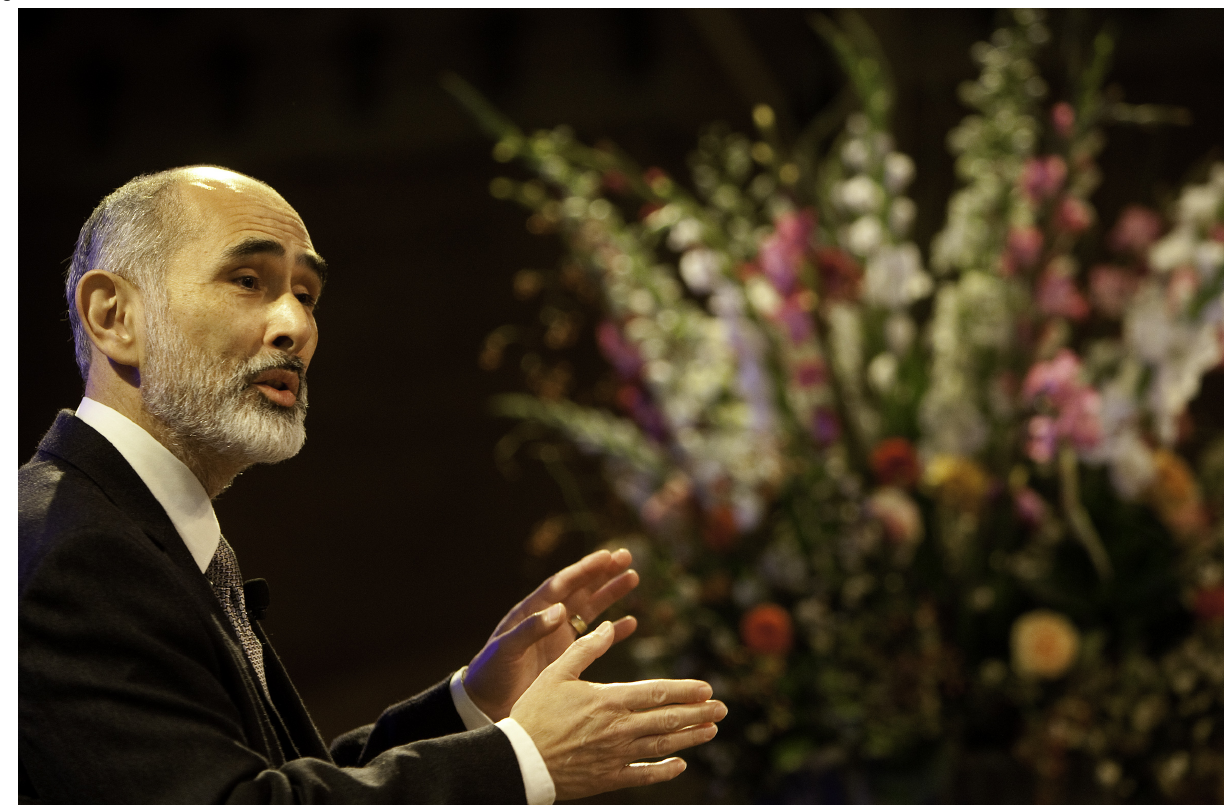
Figure 1. Professor Ricardo Muñoz at the E-Mental Health